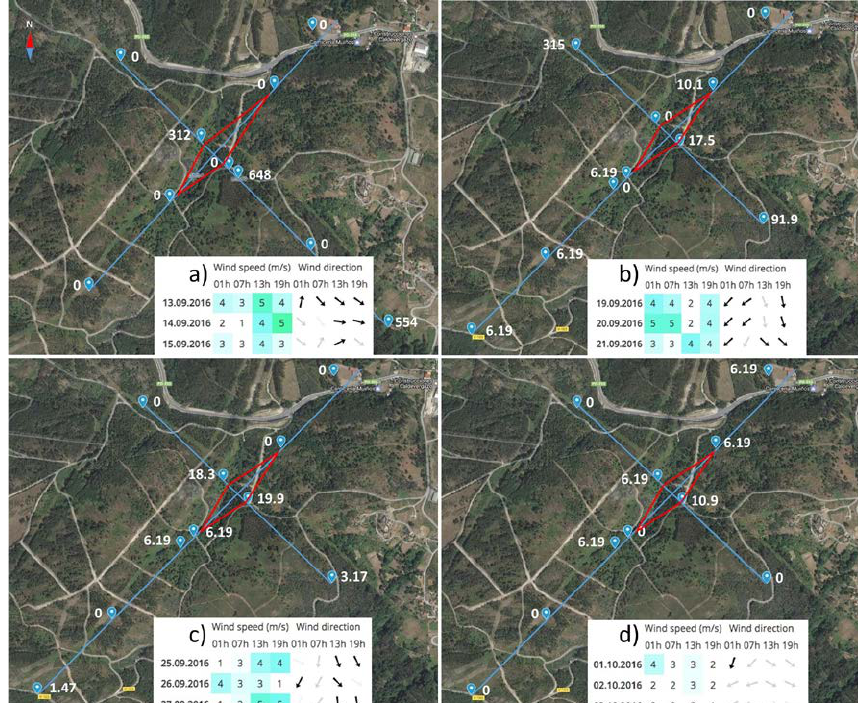
Figure 4. Results of the F. circinatum spore trapping for analysing the spatial patterns of inoculum dispersal. The four panels correspond to the four samplings carried out (13– 15 September ( a ), 19–21 September ( b ), 25 – 27 September ( c ), 1–3 October ( d )). For each sampling period, traps (blue drops) were established following a Latin cross arrangement (blue line) with the longest line following the forecasted wind direction (NW in a, and NE in b, c, and d) (see more details in the main text). Within each panel, the white numbers show the copies of the target sequence in 1 uL of template DNA (CN) detected by the rotating arm spore traps. The red continuous line connects the crosses of the four axes with the border of the infested stand (i.e., the limit of the infested stand in each orthogonal direction). Tables at the bottom of each panel reflect the real wind speed and direction measured during each sampling period.